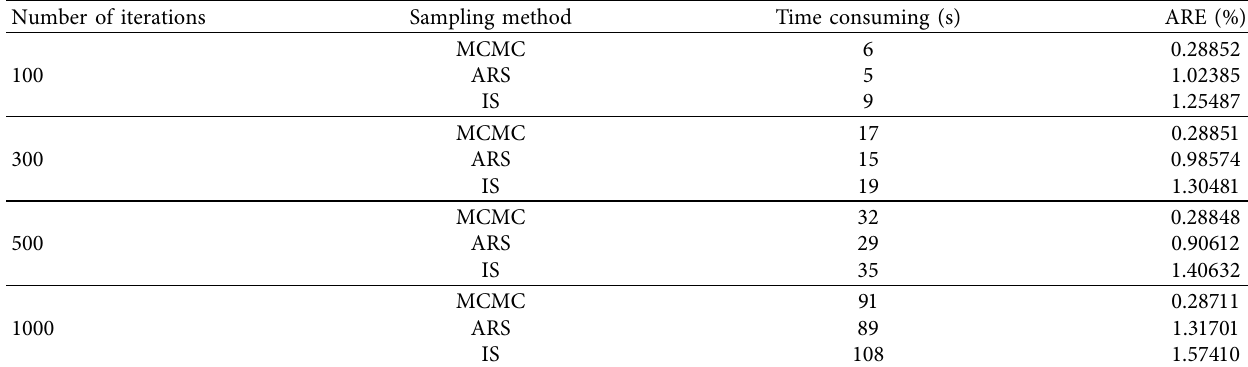
Table 4: Analysis of algorithm time consumption.